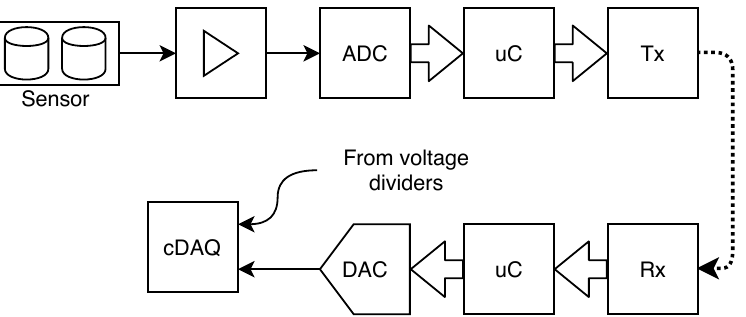
Figure 8. Block diagram of a voltage acquisition and data transmission